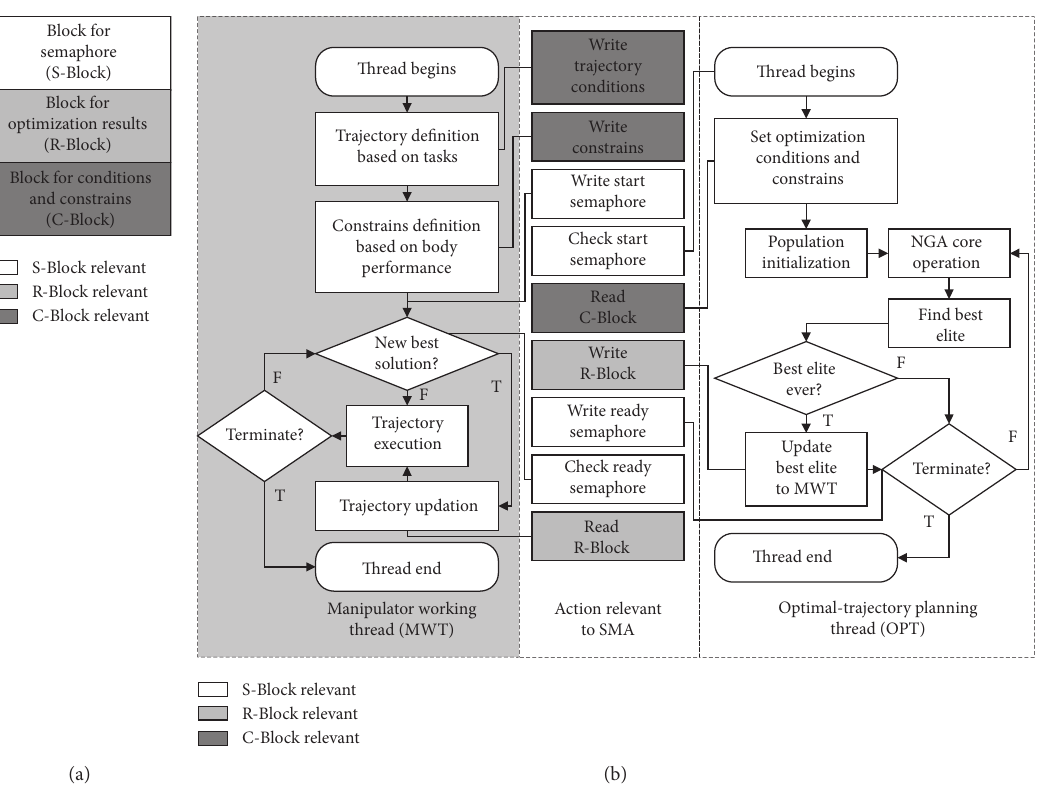
Figure 3: (a) Shared memory area. (b) Dual-thread